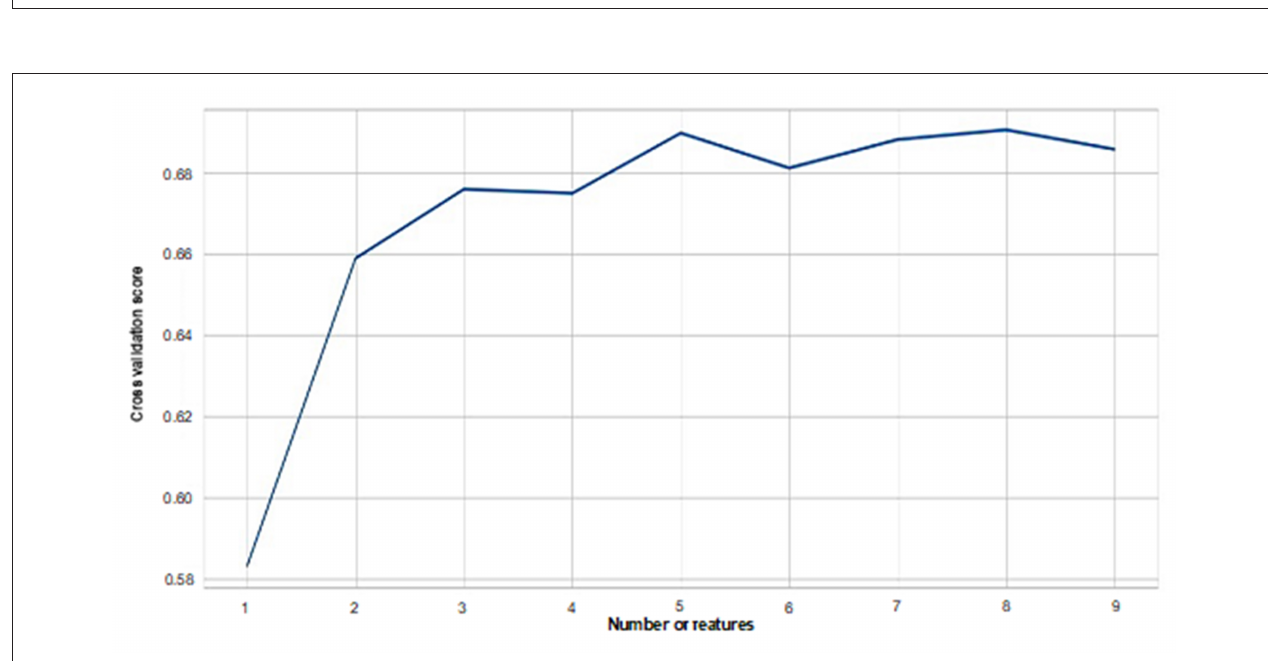
FIGURE 2 | Importance of each heart rate variability indicator. The importance scores of each feature in the prediction of emotions based on the nine heart rate variability indicators using random forest are plotted. CVRR, coefficient of variation R-R interval; SDNN, standard deviation of all NN intervals; RMSSD, square root of the mean squared differences of successive NN intervals; NN50, number of interval differences of successive RR-intervals > 50ms; pNN50, the proportion derived by dividing NN50 by the total number of RR-intervals; LF, frequency domain features include low frequency; HF, high frequency; LF/HF, the ratio of low frequency to high frequency.